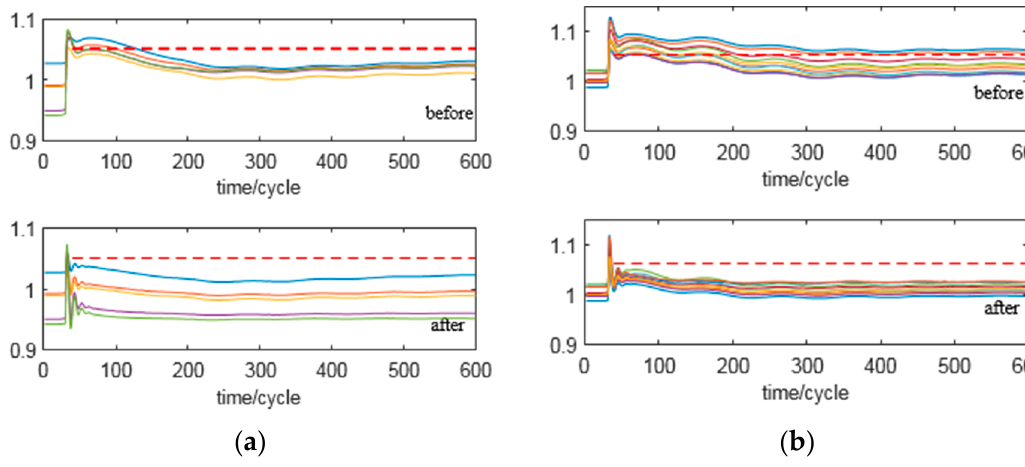
Figure 8. Voltage trajectory before/after compensation. ( a ) Scenario 1; ( b ) Scenario 2.